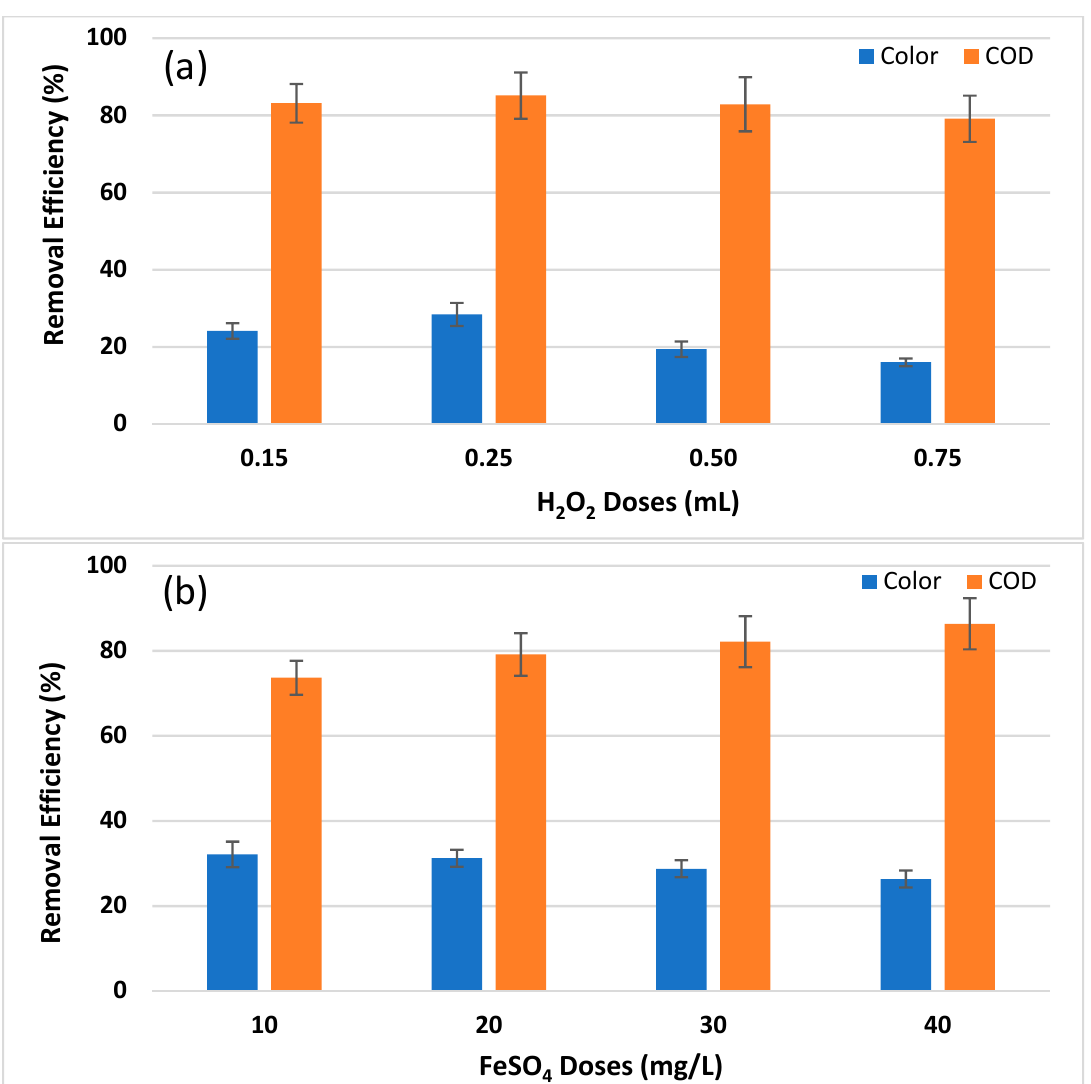
Figure 6. ( a ) Optimization of H 2 O 2 dose of raw pulp and paper wastewater for Fenton oxidation at different doses (0.15, 0.25, 0.50 and 0.75 mL). ( b ) Optimization of FeSO 4 dose of raw pulp and paper wastewater for Fenton oxidation at different doses (10, 20, 30 and 40 mg/L). Means values are presented with standard deviation.